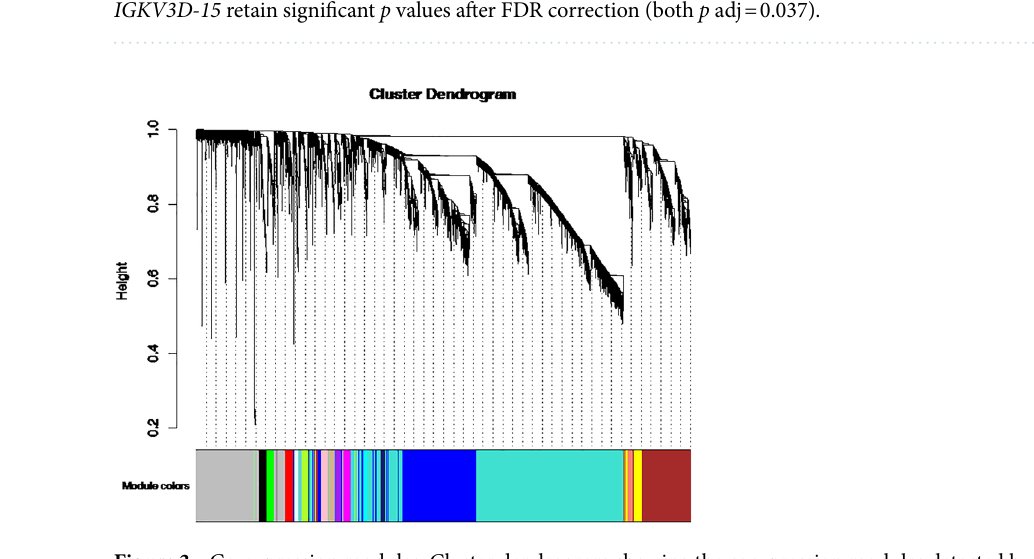
Figure 3. Co-expression modules. Cluster dendrogram showing the coexpression modules detected by WGCNA